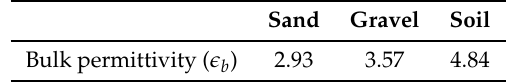
Table 2. Estimated bulk permittivity for the three materials using Equation (4).